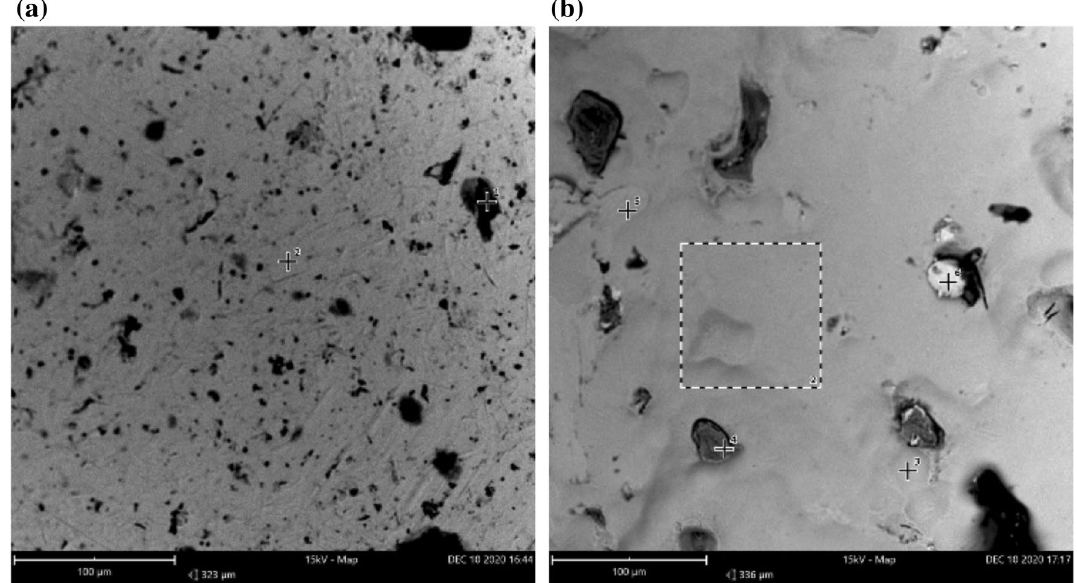
Fig. 2 Images under a different Scanning Electronic Microscope which reveal internal defects for Bone Easy ( a ) and BTK ( b ) meshes. In par- ticular the device a shows numerous small defects (ranging between 2 µm and 15 µm), while the device b presents less defects with an average diameter of 20